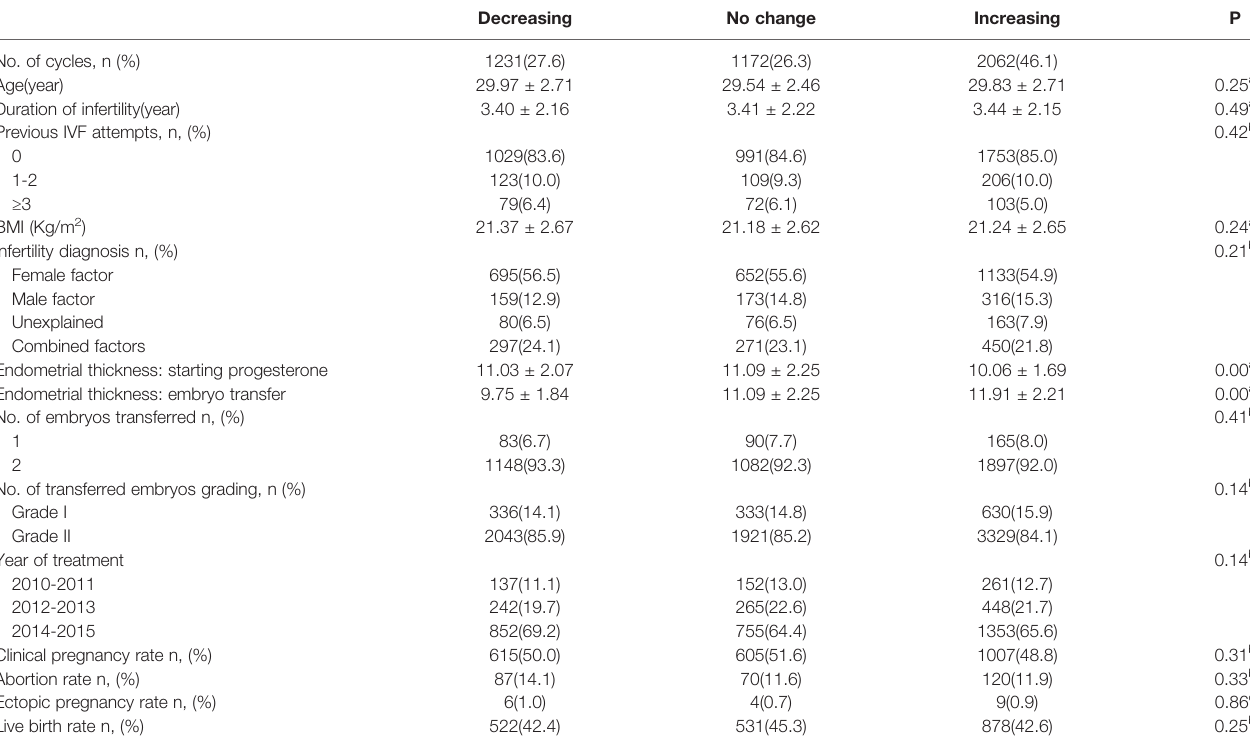
TABLE 1 | Basic characteristics and pregnancy outcomes in women transferred with Day 3 frozen-thawed embryos. Decreasing No